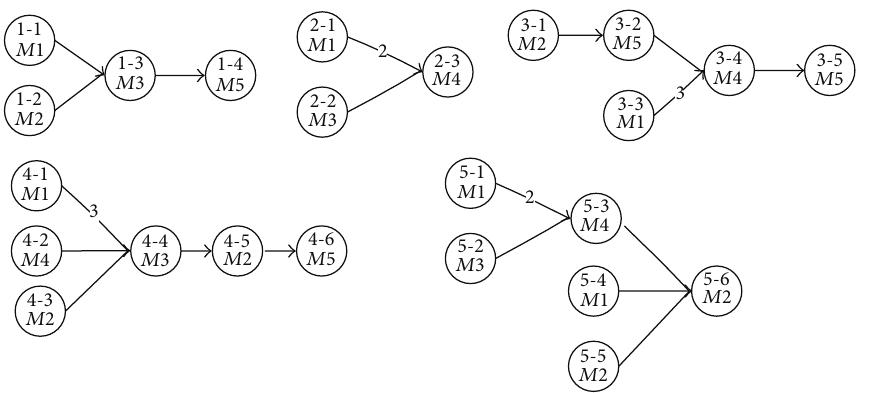
Figure 1: Examples of product tree